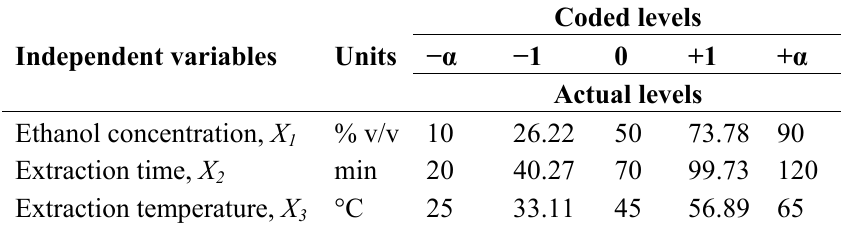
Table 5. Levels of independent variables established according to the central composite rotatable design